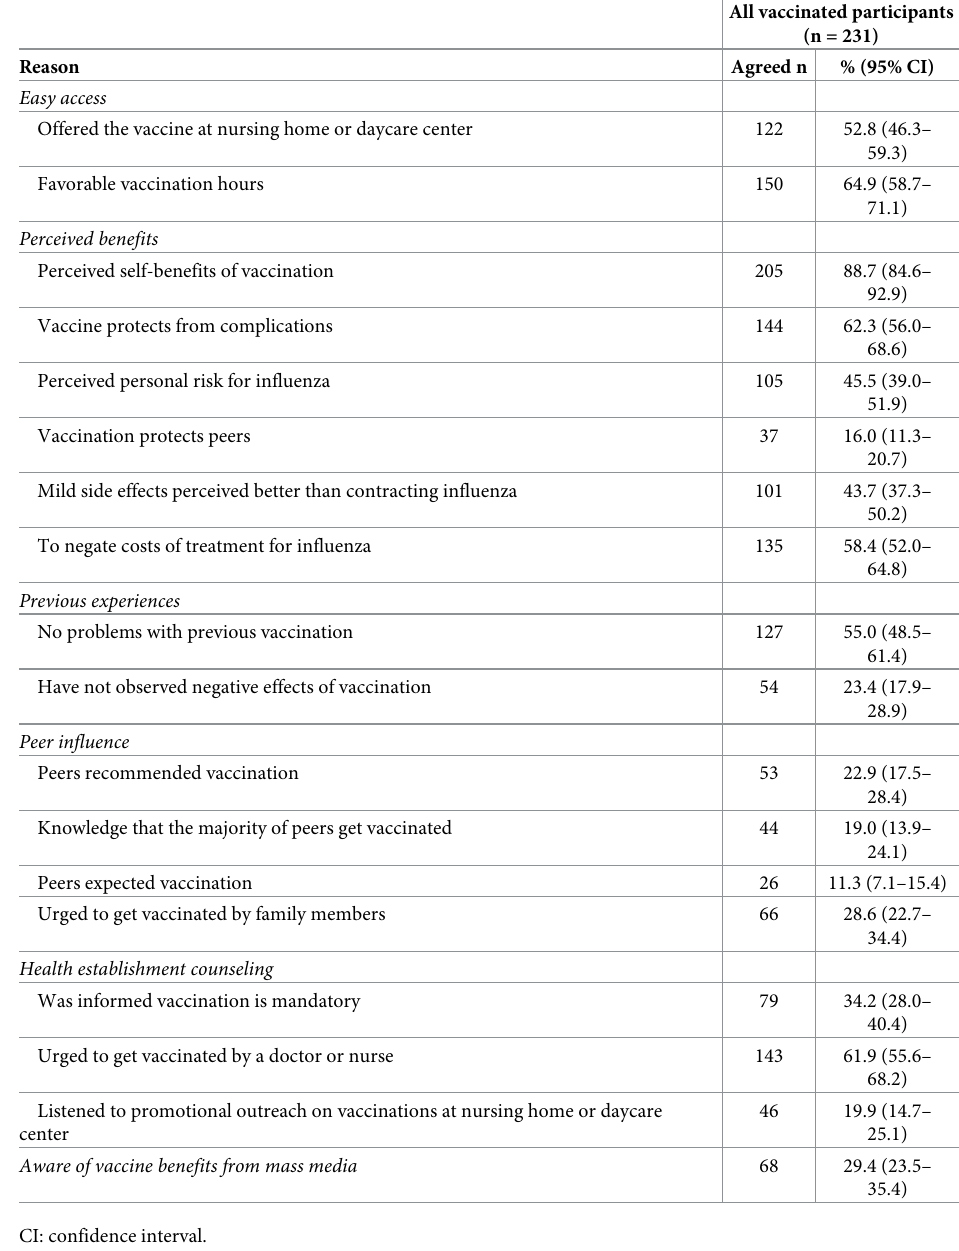
Table 4. Reasons for receiving influenza vaccination, older adults in nursing homes and daycare centers a , Hondu- ras, August 29 to October 26,